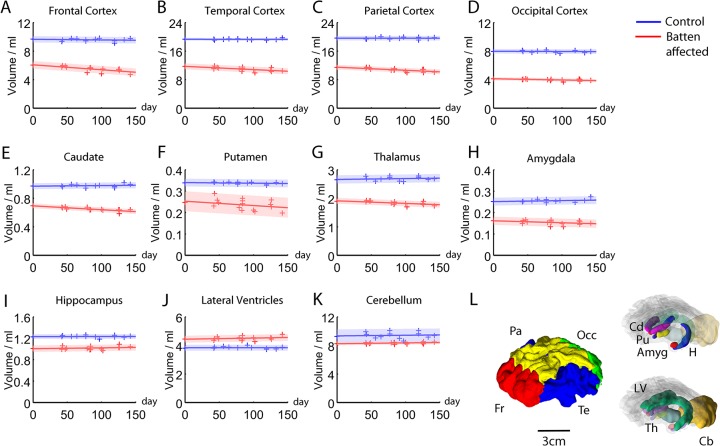
Regional volume changes in Batten disease sheep.Volumes are shown for control (blue) and Batten affected sheep (red) of cortex (A-D), basal ganglia (E-F), thalamus (G), amygdala (H), hippocampus (I), lateral ventricles (J) and cerebellum (K) with 3D reconstructions of the regions measured shown in L. Day 0 is the day of the baseline scan. Solid lines show a least-squares linear fit, the shaded region extends two standard deviations either side of the line. Volumes were normalised as described in the text.